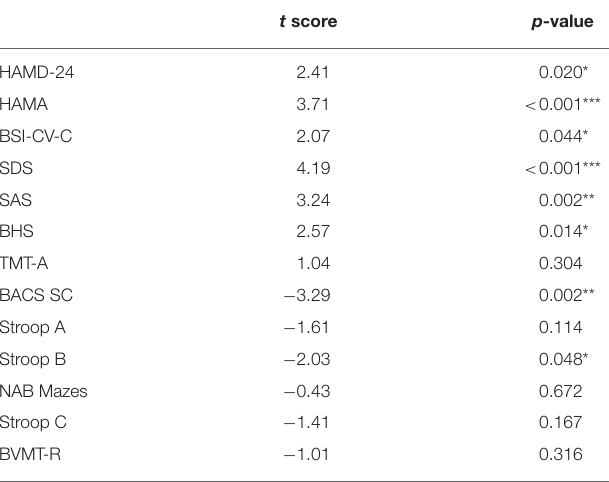
TABLE 1 | ATIII at baseline involved in prediction of therapeutic effects.